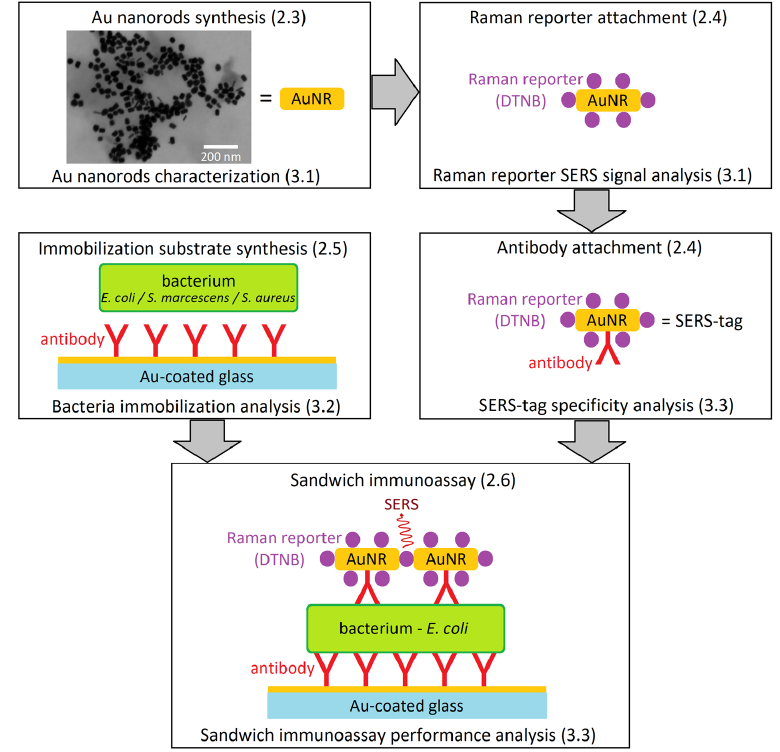
Figure 1. Work-flow diagram leading to the sandwich immunoassay for E. coli detection with SERS- tags. (Schematic depiction—parts not to scale.) The numbers in parentheses refer to the article sections dealing with methodology (2.x) and results (3.x) of the individual steps. The synthesis of AuNRs is followed by their characterization with electron microscopy. Reporter molecules are then attached to the AuNRs and their SERS signal is analyzed. Subsequent antibody attachment provides a complete SERS ‐ tag. Au ‐ coated glass is derivatized with antibodies and the immobilization of bac ‐ teria is tested. In the final step, the branches of the diagram unite to afford the sandwich immuno ‐ assay, and its analytical performance is tested with multiple bacterial species.